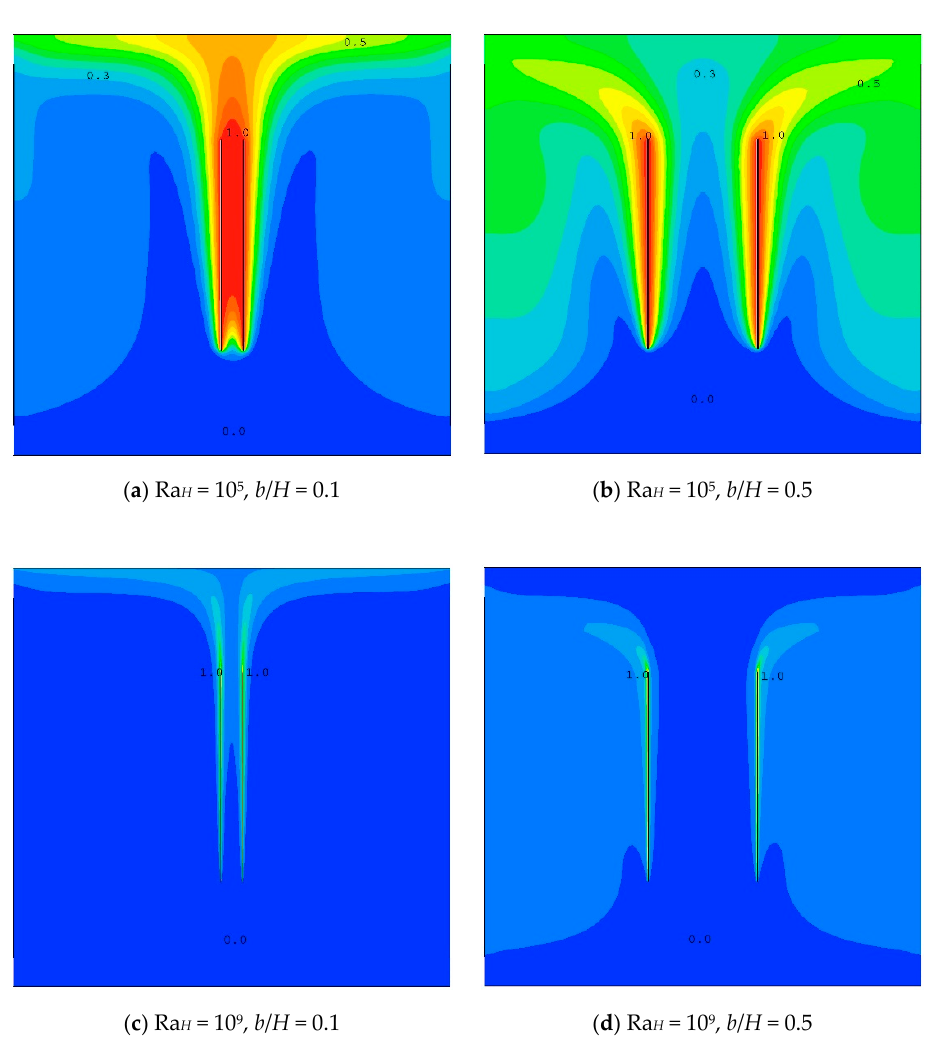
Figure 9. Filled temperature distribution for different Rayleigh numbers and aspect ratios, including representative values of θ = ( T − T ∞ ) / ( T w − T ∞ ), from 0 (cold fluid, blue color) to 1 (heated fluid, red color). Configuration is given in Figure 1b. Heating parameter Λ = 0.01.